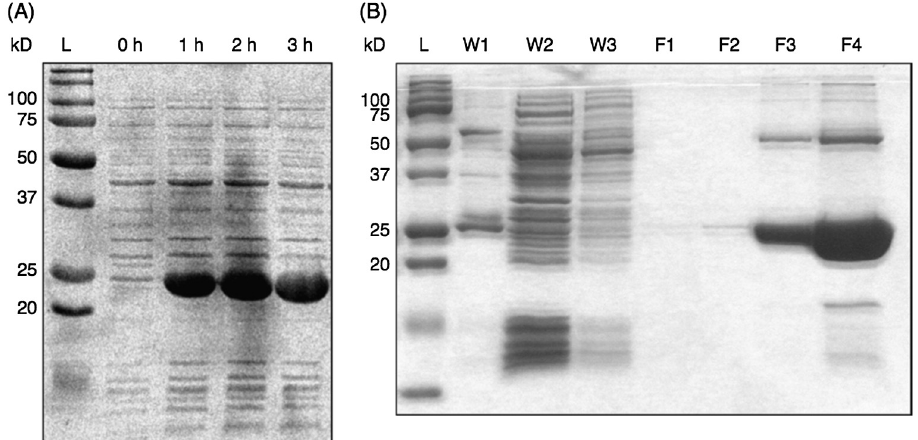
Figure 4. (A) SDS-PAGE analysis of E. coli whole cell lysates before and after the induction of UPRT expression. Lane L, protein size- standard ladder with the molecular weight (kD) labeled next to each band. The time after induction of protein expression is labeled above each lane. (B) SDS-PAGE analysis of fractions collected during the puri fi cation of the UPRT enzyme by His-tag af fi nity chromatography. Lane L, protein size-standard ladder with the molecular weight (kD) labeled next to each band. Wash fractions are labeled W1, W2, and W3; elution fractions are labeled F1, F2, F3, and